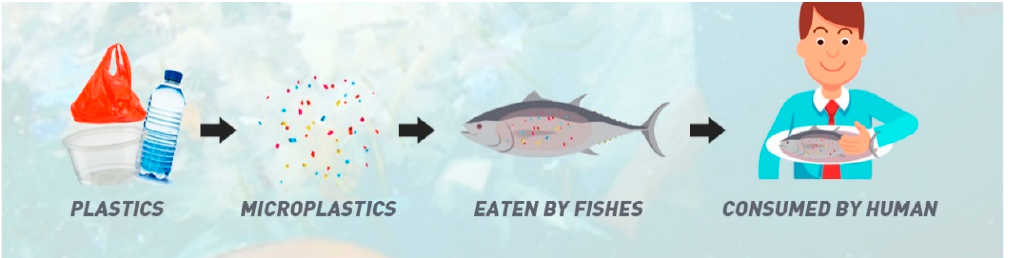
Figure 1. Sources and Modes of MPs Transmission. Illustration with permission from Jay Weaver © 2020 Design conscious [18] .